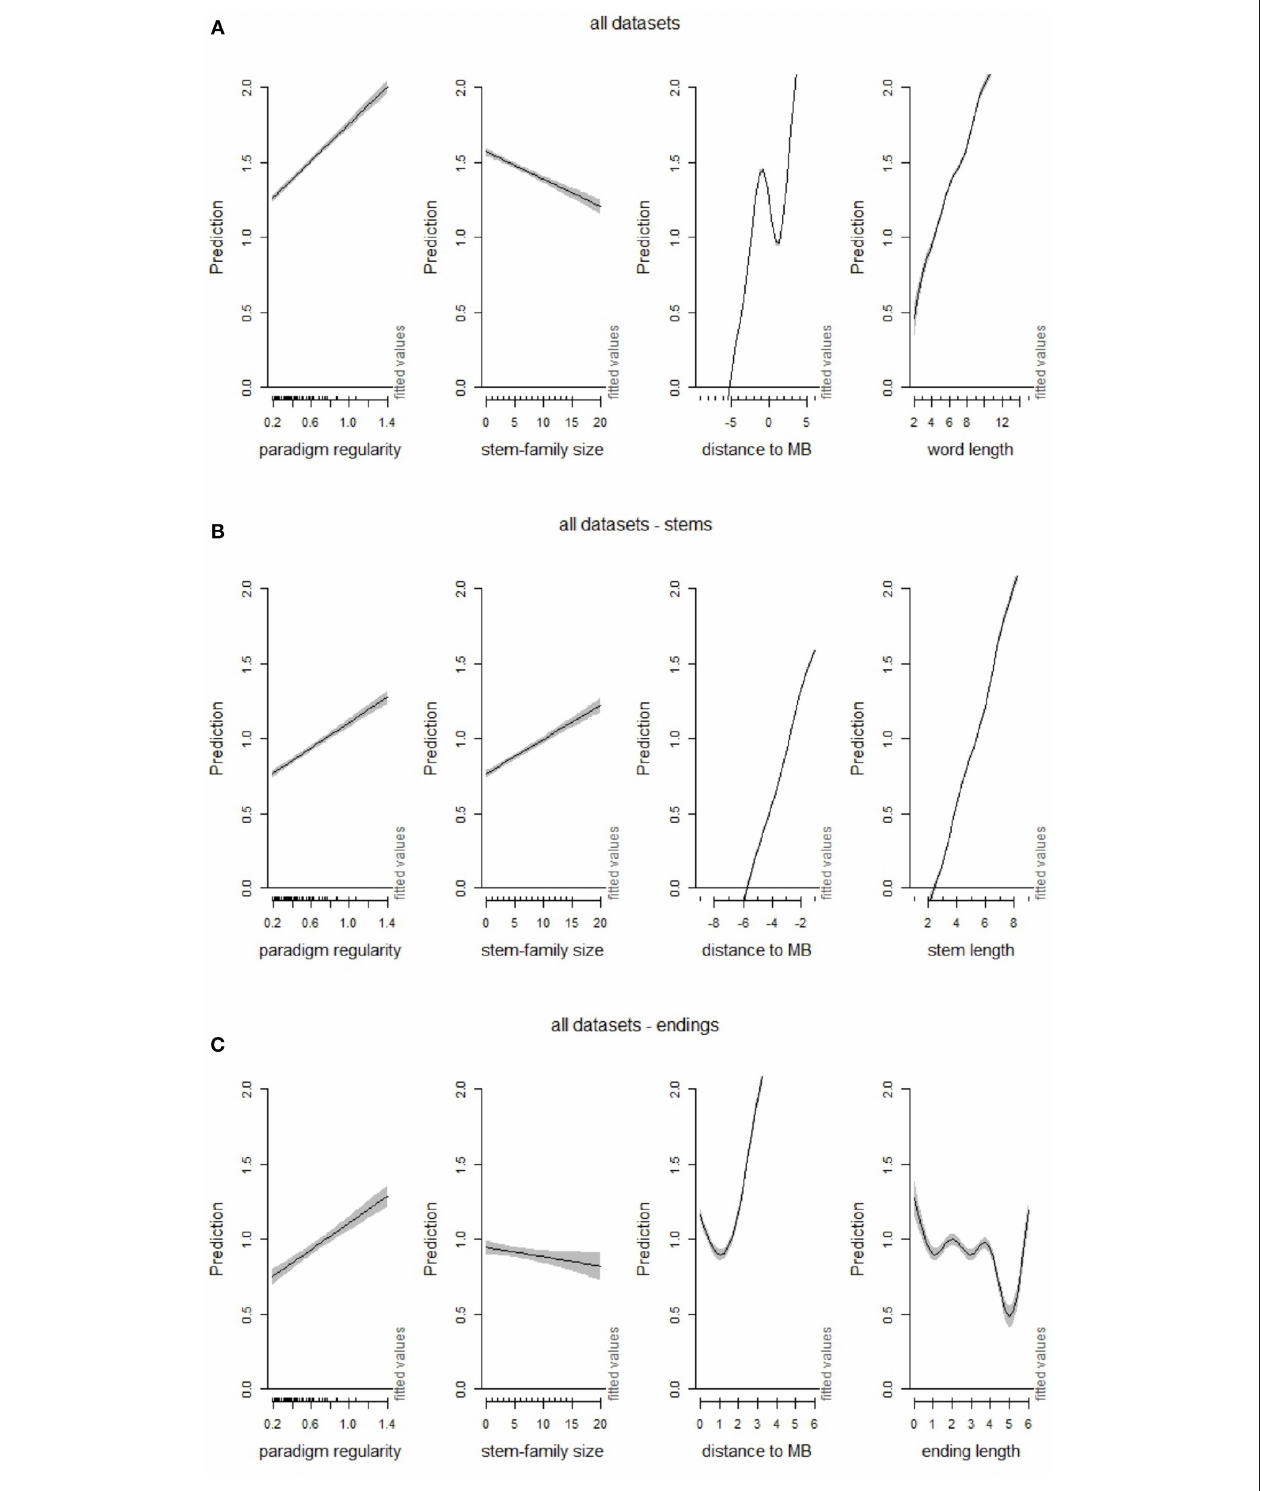
FIGURE 8 | Effects of (graded) paradigm regularity interacting with stem-family size, distance to stem-suffix boundary ( MB ) and (word, stem and suffix) length in GAM s modeling TSOM prediction rates in: (A) word processing, (B) stem processing, and (C) suffix processing. The specified predictors are taken in interaction with paradigm regularity as summed effects ( itsadug package, plot_smooth function).